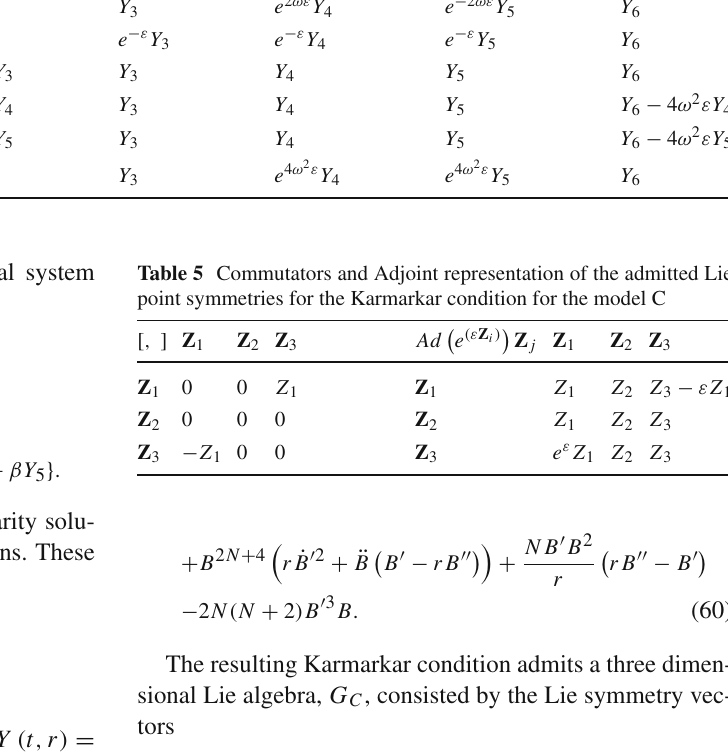
Table 4 Adjoint representation for the admitted Lie point symmetries for the Karmarkar condition for the Weyl-free collapse spacetimes (cid:14) (cid:15) Ad e (ε Y i ) Y j